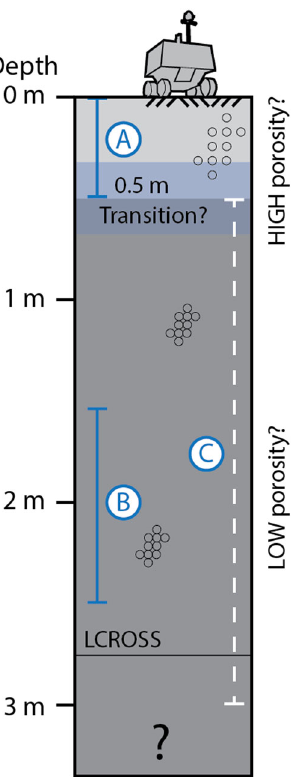
Fig. 8 Permanently shadowed region regolith surface and subsurface characteristics. Sketch of inferred lunar PSR (permanently shadowed region) surface and subsurface characteristics, based on this work and literature (see discussion). A Layer of potentially highly porous regolith, as suggested e.g., by FUV-dark (far ultra-violet) PSR surfaces and the lack of illumination-driven densi fi cation processes in PSRs 8, 15, 40 – 42 , < ~0.5 m depth; B layer of high shear strength regolith as indicated by potentially distal, rockfall/impact-deposited intra-PSR boulders (> ~1.5 to 2.5 m depth); C depth range where high intra-PSR shear strength regolith has been reported in low-latitude PSRs, but with some uncertainty about the depth estimates caused by secondary illumination 48 . The LCROSS (Lunar CRater Observation and Sensing Satellite) Centaur stage created an impact crater with an estimated diameter of 25 to 30 m 8 ; using a d/D ratio of 0.1 as suggested by 69 , LCROSS would have reached a depth of ~2.5 to 3 m, i.e., represents the deepest sample of a PSR to date. Rover not to